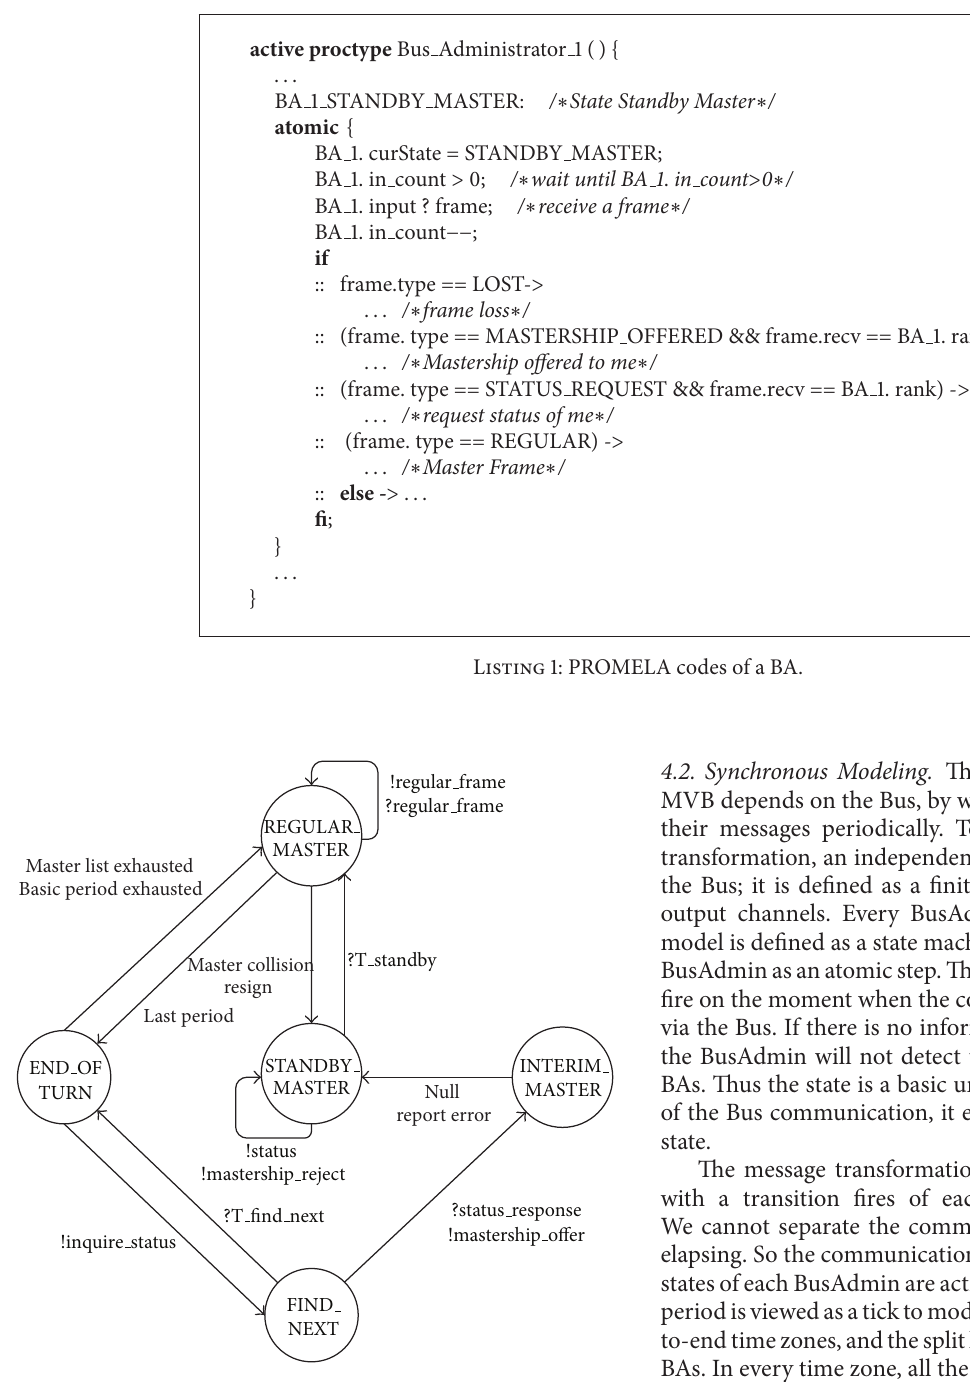
Figure 8: States and transitions of a